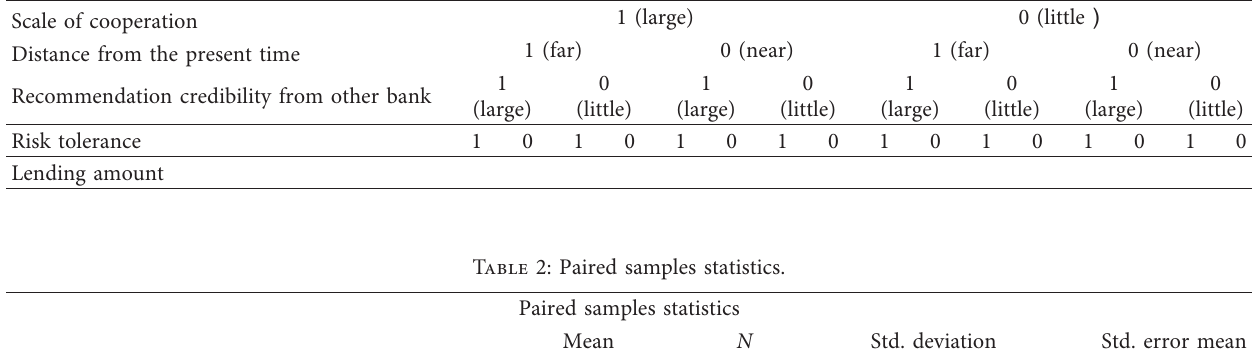
Table 1: Decision to lend